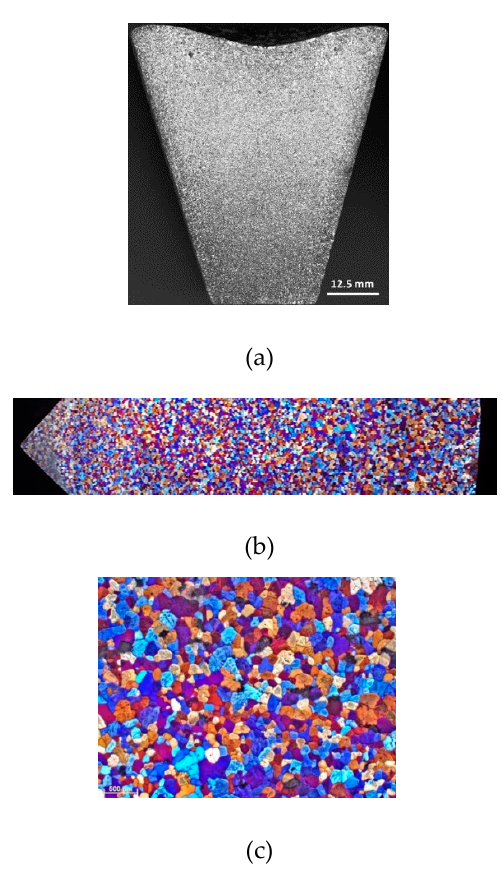
Figure 5. Effect of Al5Ti1B grain refiner addition and same-alloy rod introduction into the melt in the temperature range 710 to 670 °C on the grain structure of the alloy cast in a TP1 mould: ( a) , macrostructure; ( b , c) microstructure.